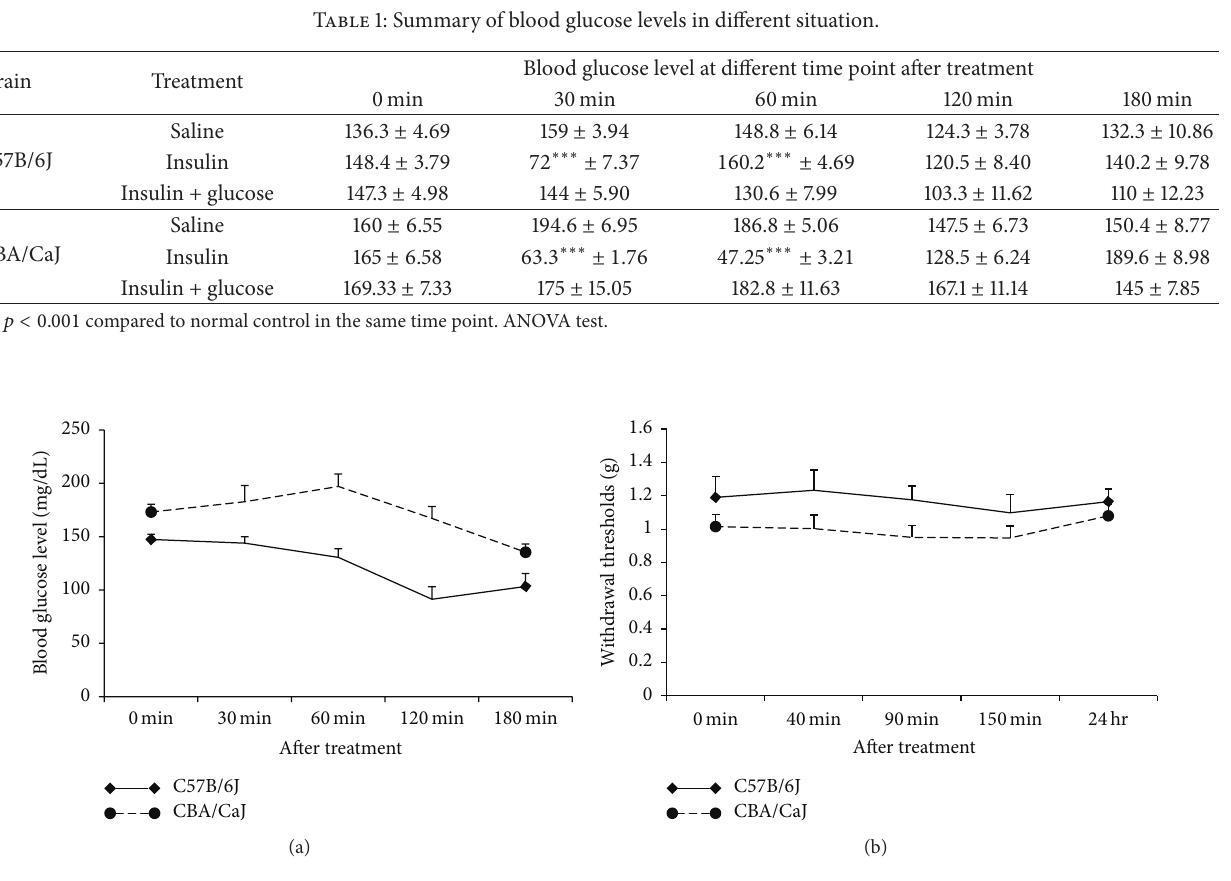
Figure 2: The effect of combined glucose and insulin injection on mechanical sensitivity. (a) demonstrates stable blood glucose levels after combined injection. (b) indicates that withdrawal thresholds showed no significant change after simultaneous injection of 1unit/kg of insulin and 3.18g/kg of